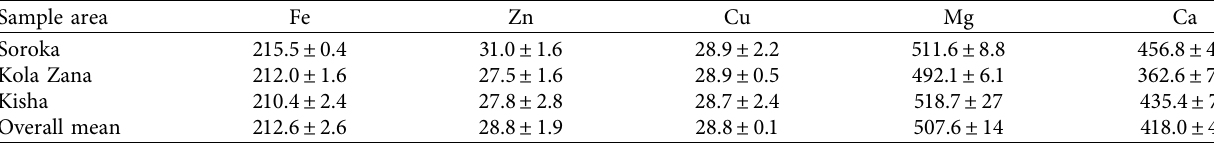
Table 7: Concentration (mg/kg, dry weight) of metals in soil samples from three sesame growing areas of Tsegede, Ethiopia. Sample area